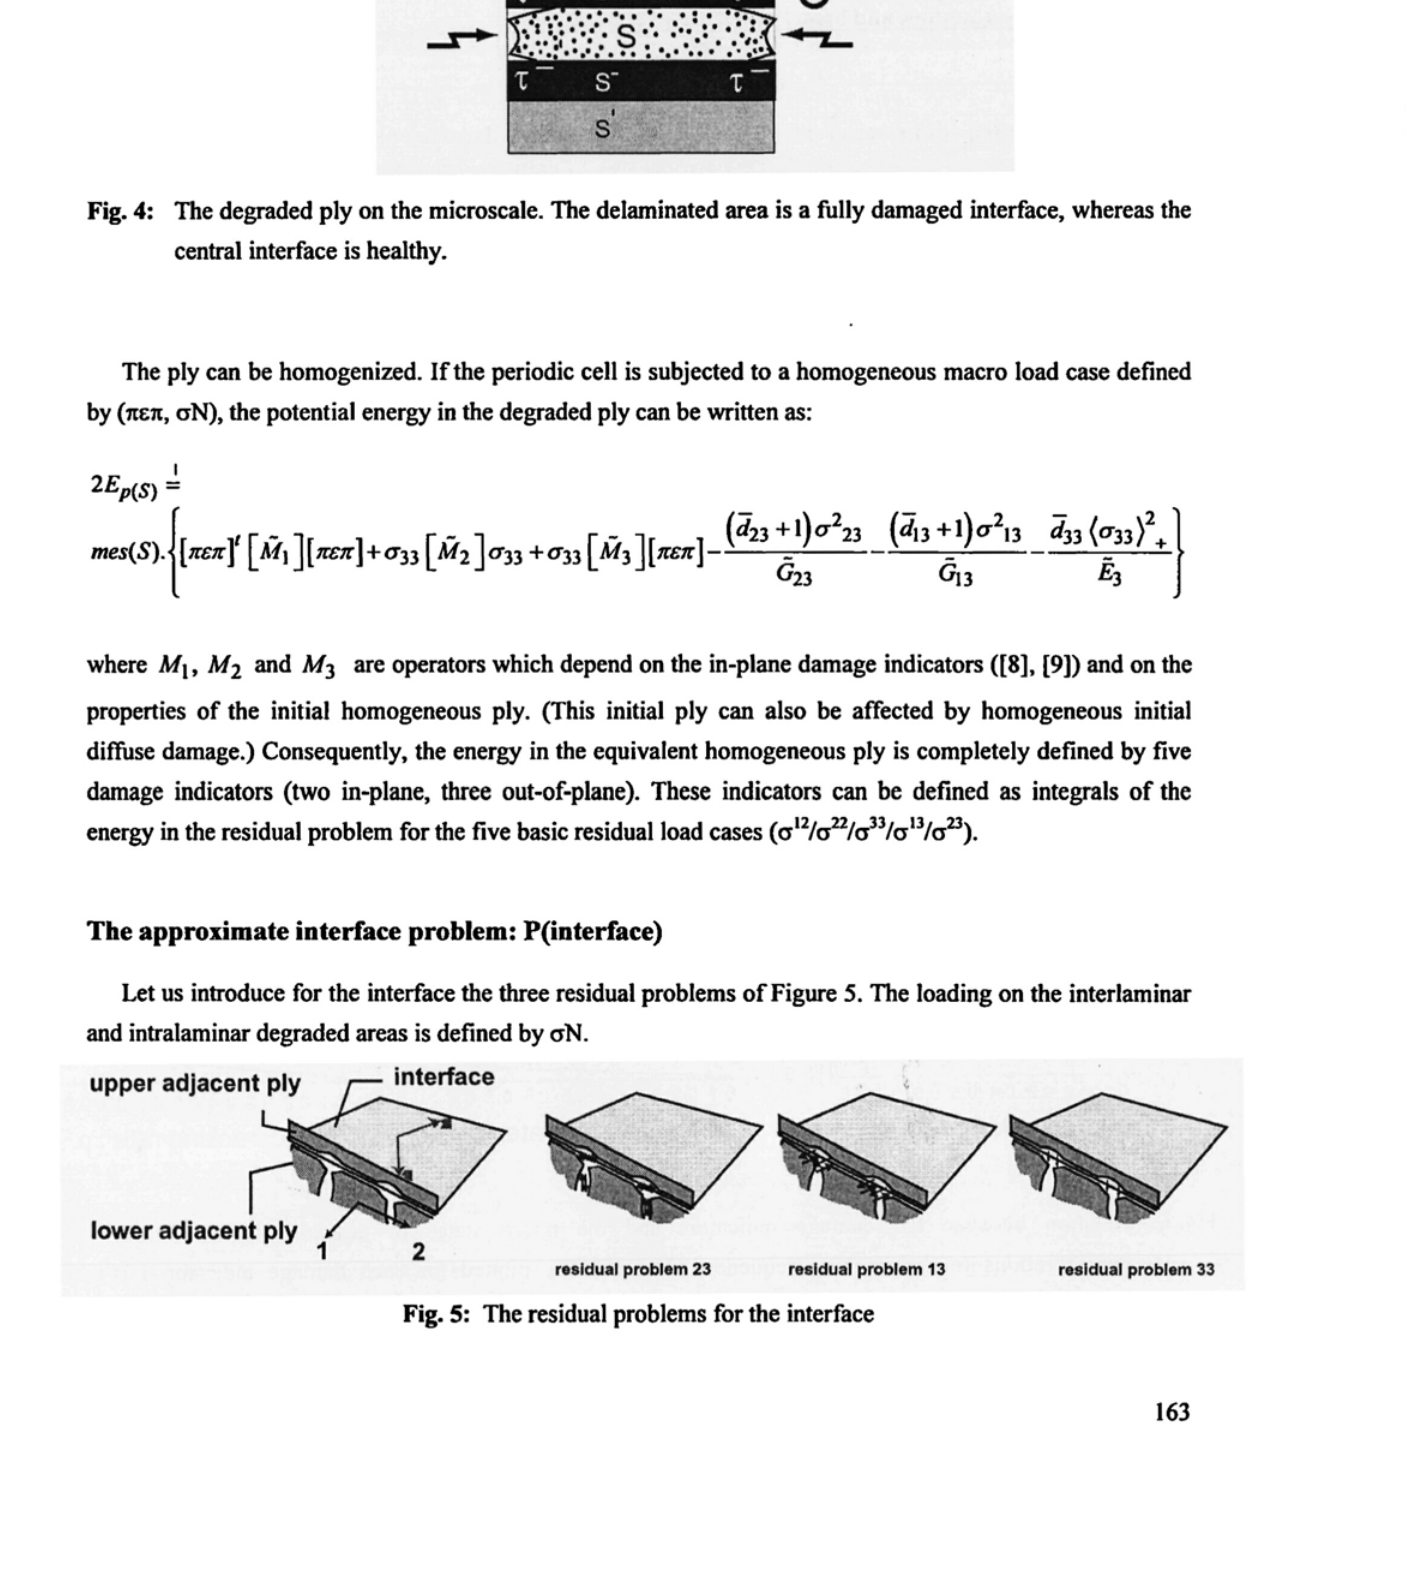
Fig. 4: The degraded ply on the microscale. The delaminated area is a fully damaged interface, whereas the central interface is healthy.